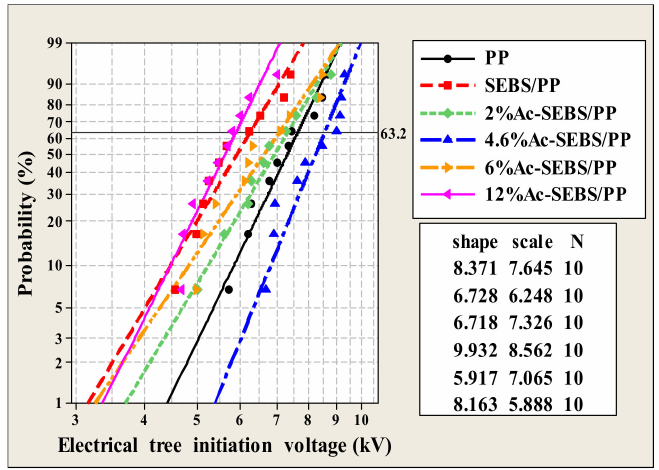
Figure 7. Weibull distribution of the electrical tree initiation voltage of PP and its composites.